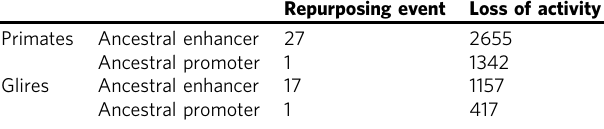
Table 2 Turnover of regulatory elements activity in primates and